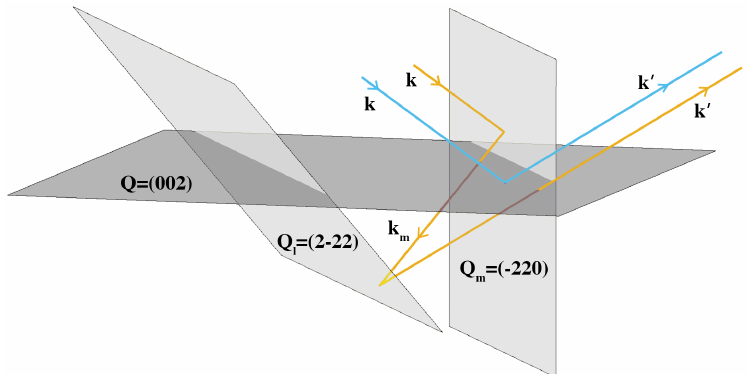
Figure 1. In general, the X-ray reflection intensity is composed of two-wave and three-wave parts. Here, in the case of two-wave reflection (blue line), the incident wave with the wave vector k is reflected from the family of planes ( 002 ) and on the output has a wave vector k (cid:48) , where k (cid:48) = k + Q . In the case of three-wave reflection (orange line), the wave k is reflected first by the planes ( − 220 ) , then by the planes ( 2 − 22 ) and on the output has the same wave vector k (cid:48) , where k (cid:48) = k m + Q − Q m .